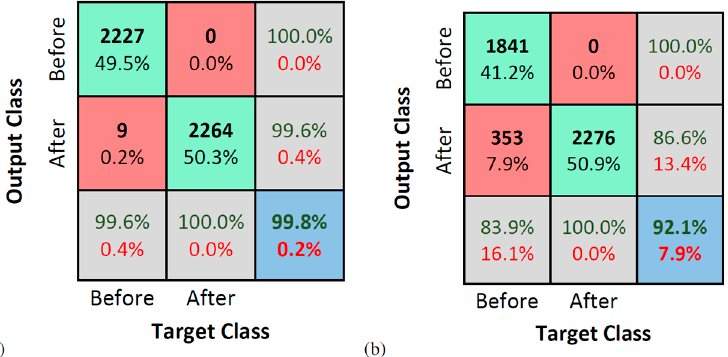
Figure 13. Várzea Nova viaduct: Confusion matrices—50 SAE internal codes. ( a ) Accelerometer 1. ( b ) Accelerometer 2.